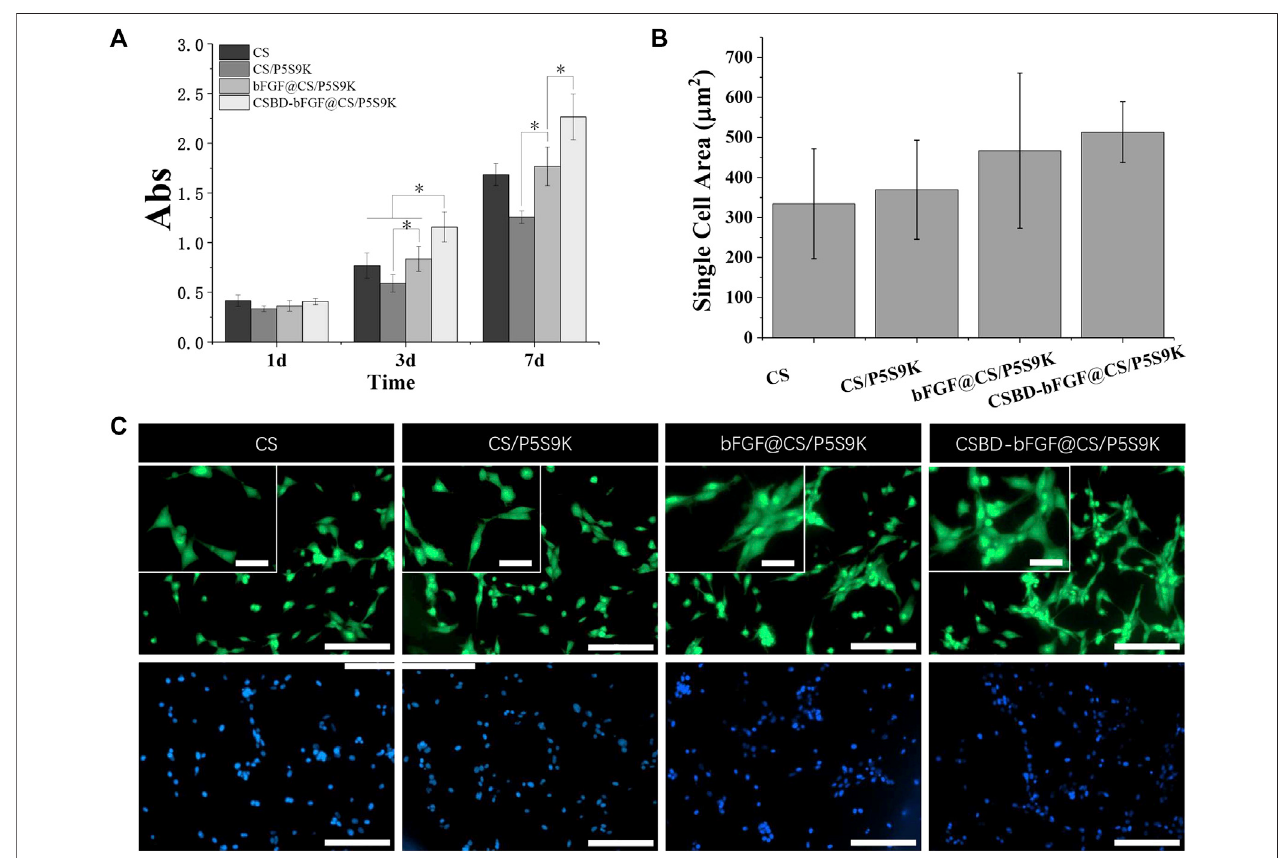
FIGURE6|(A) CCK-8testofNIH3T3cellproliferationonCS,CS/P5S9K,bFGF@CS/P5S9KandCSBD-bFGF@CS/P5S9Kmembranesfor1,3and7days. (B-C) Fluorescent micrographs and cell area analysis of NIH3T3 cells on CS, CS/P5S9K, bFGF@CS/P5S9K and CSBD-bFGF@CS/P5S9K membranes for 2 days. The green fl uorescent indicated the cell morphology stained with FITC, the blue fl uorescent indicated the cell nucleus stained with DAPI. Small scale bar lengths are 50 μ m, large scale bar lengths are 200 μ m, n = 3, p <